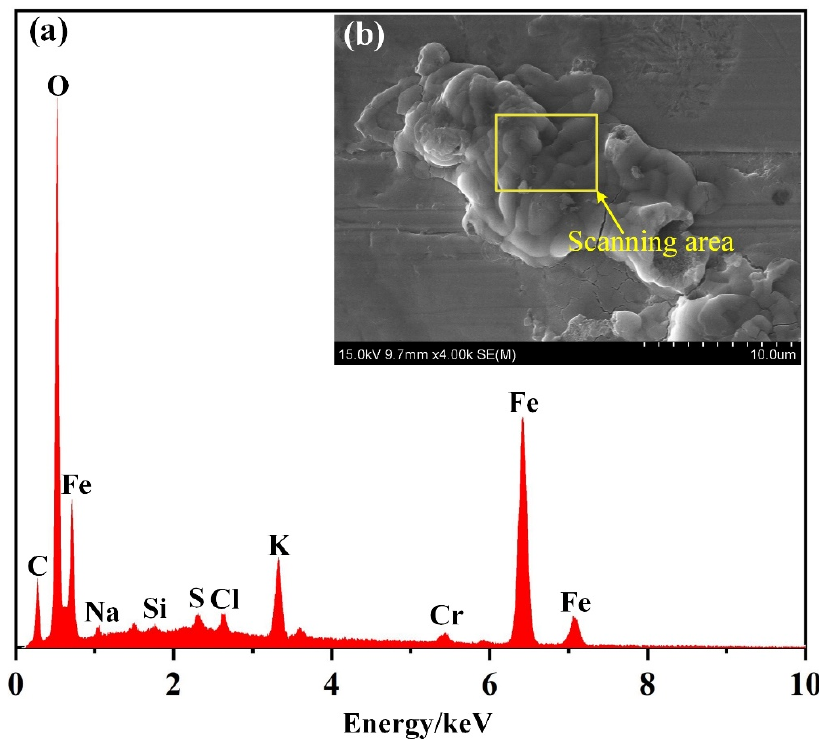
Figure 9. ( a ) EDS analysis of the oxide particles; and ( b ) scanning area.